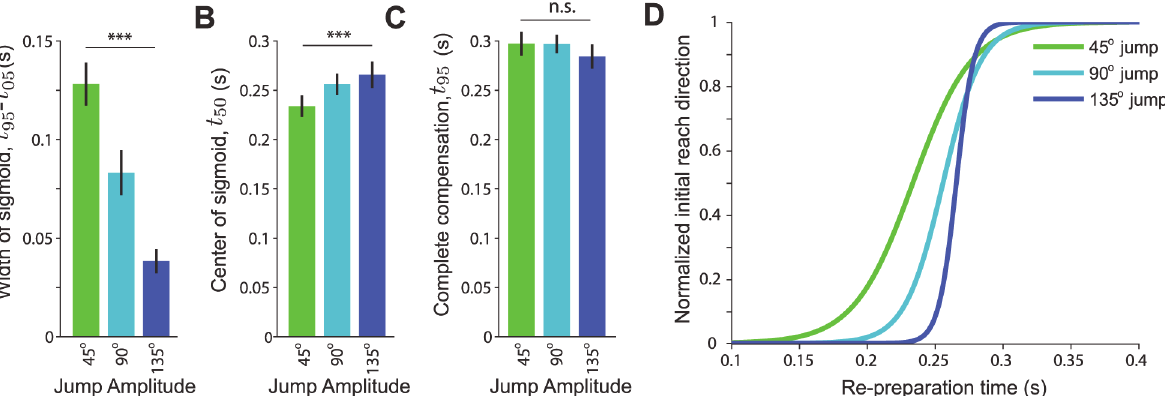
Fig 3. Group results for Experiment 1. Estimated sigmoid parameters across all subjects for each target jump amplitude. A) Total time over which reach direction varied ( t 95 – t 05 ; proportional to slope parameter, τ ). B) Center of sigmoid, t 50 . C) Time required to fully compensate for the target jump, t 95 . Error bars indicate s.e.m. D) Average sigmoidal fits to behavior across all subjects obtained by averaging parameters τ and t 50